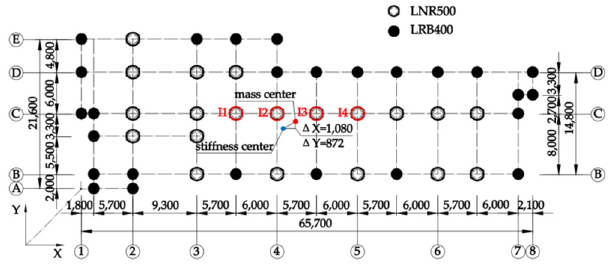
Figure 5. Layout plan of isolation bearing (Unit: mm).